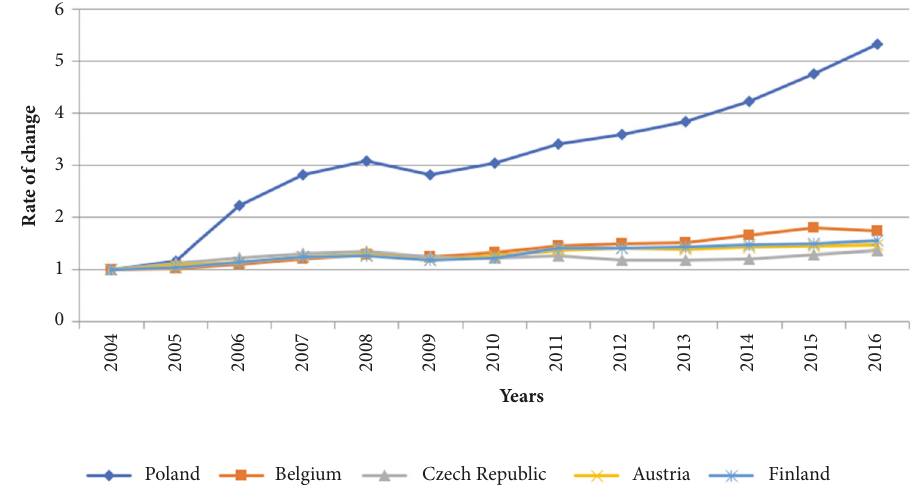
Figure 2: Rate of change over the course of the analyzed